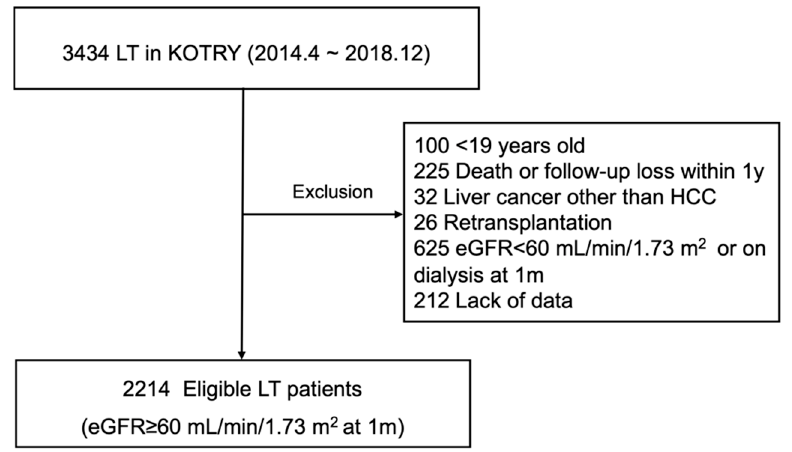
Figure 1. Selection of study population. eGFR, estimated glomerular filtration rate; HCC, hepatocellular carcinoma; KOTRY: Korean Organ Transplantation Registry; LT, liver transplantation